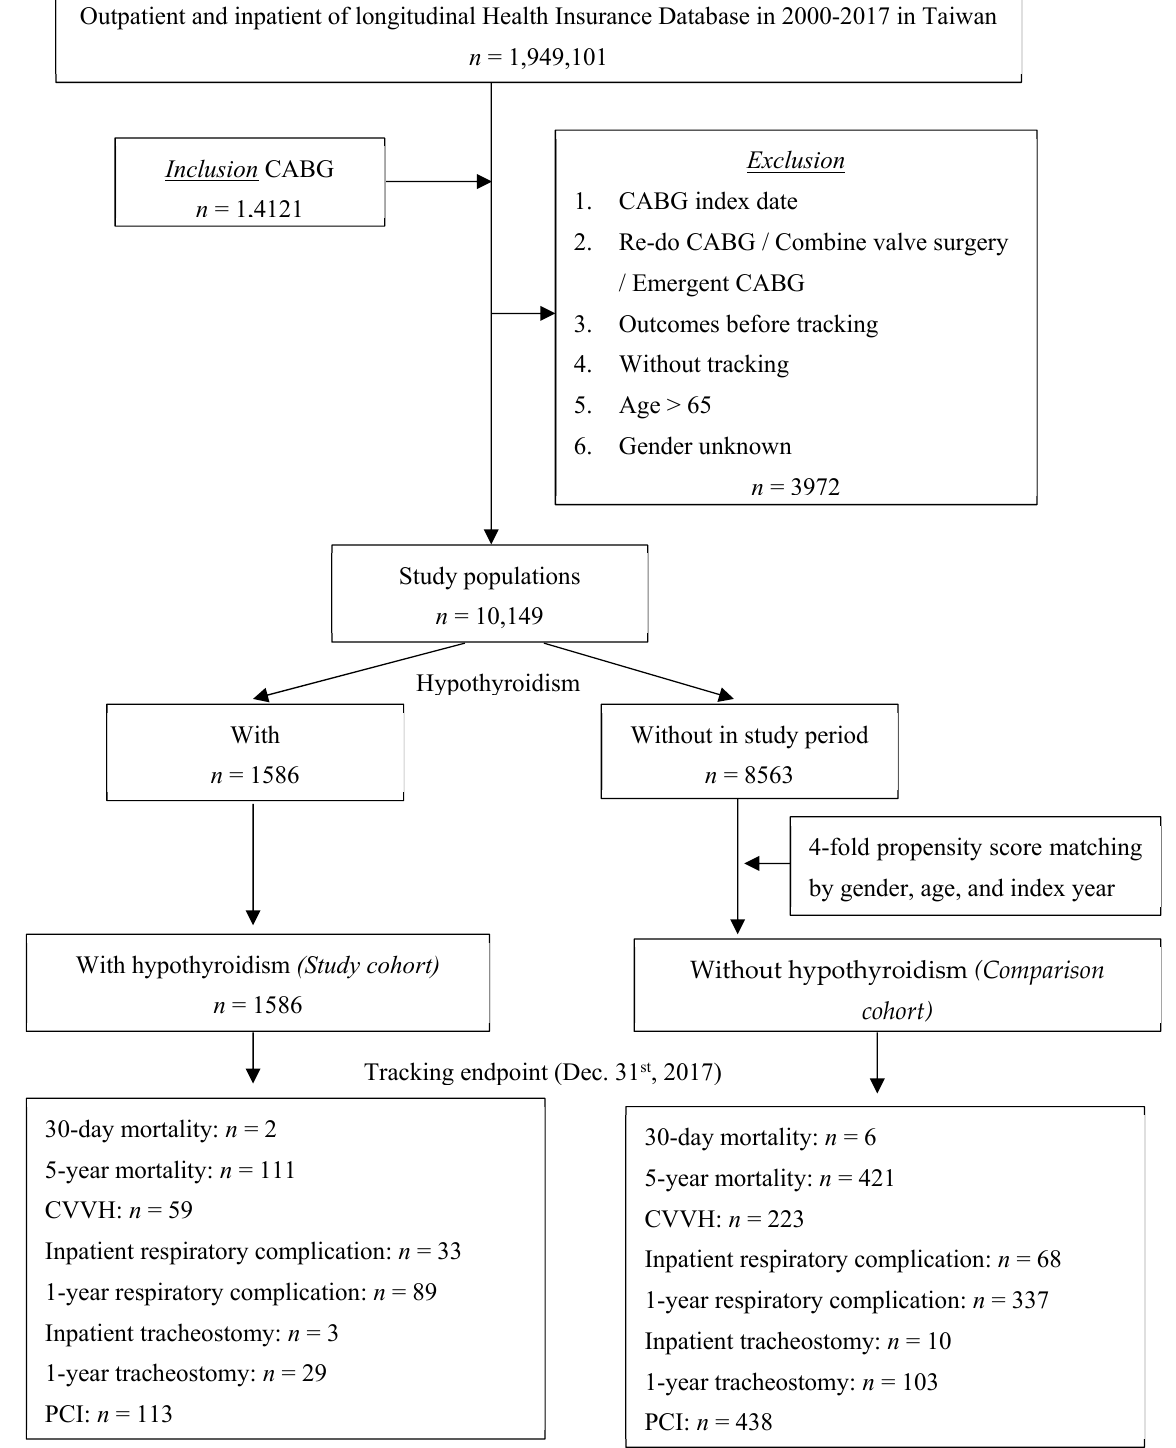
Figure 1. Flow chart of study patient selection from the National Health Insurance Research Database in Taiwan.